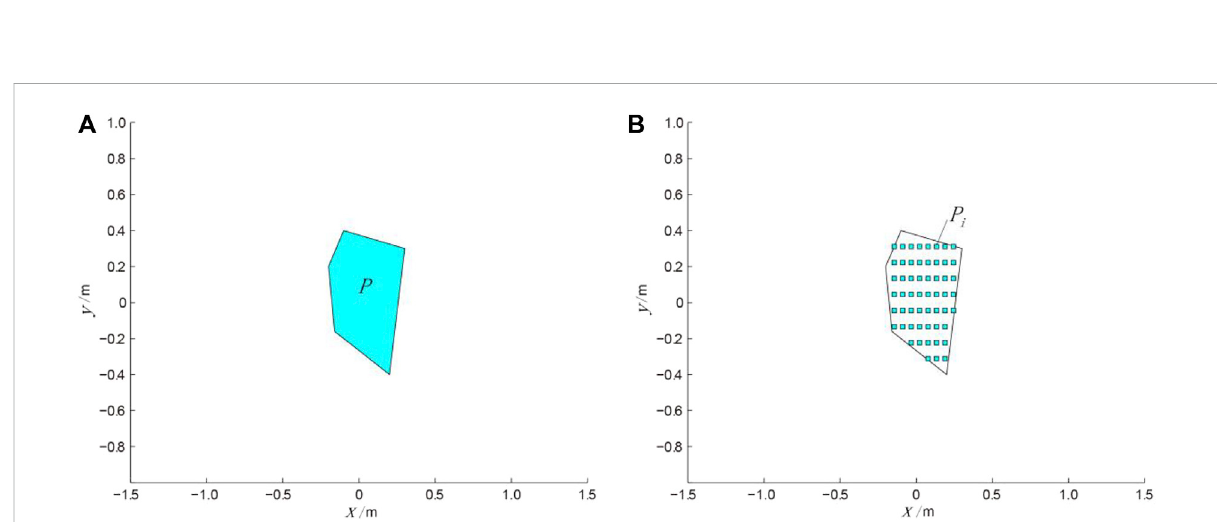
FIGURE 3 The scattering process diagram of two dimensional irregular load model. (A) Original irregular load shape; (B) the irregular Load shape after